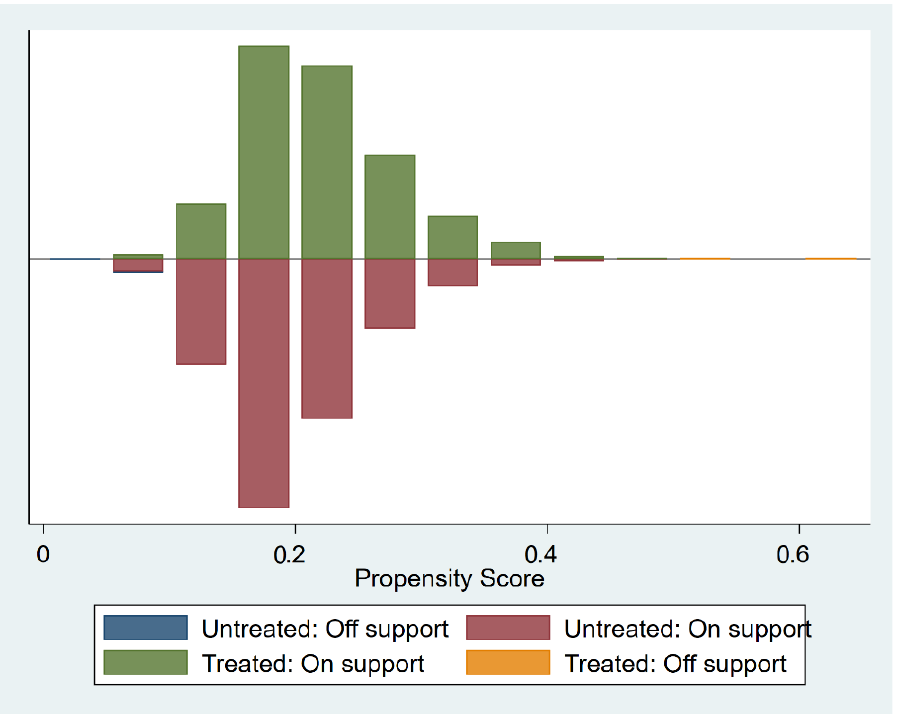
Figure 2. Propensity scores in treatment and control groups (nuclear